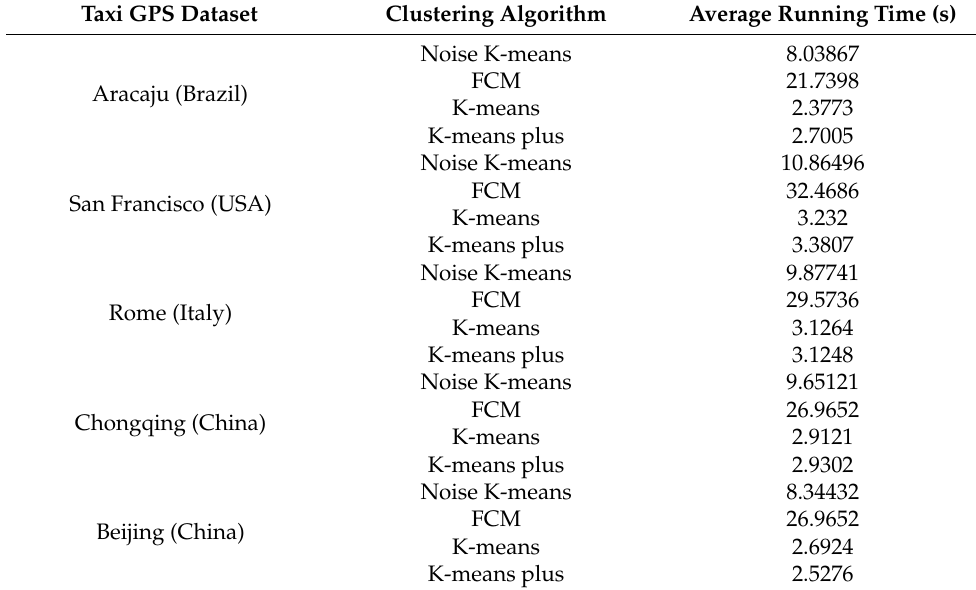
Table 7. Comparison of the average running time (s). Taxi GPS